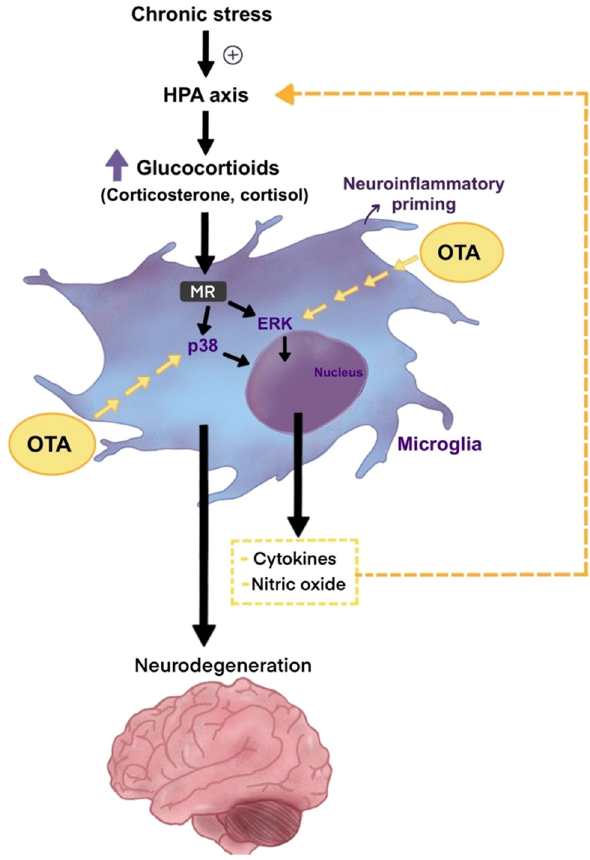
Figure 5: A proposed mechanism of how stress hormones ( glucocor - ticoids ) promote OTA - mediated microglia activation, which might lead to